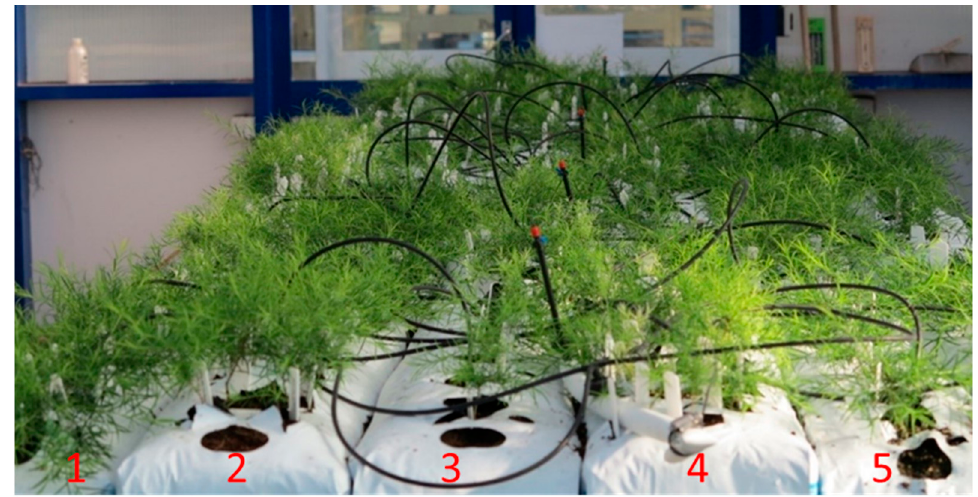
Figure 5. Stock plant growing conditions. Bag 1—(far left) pot mix high density (40 plants per bag; 200 plants/m 2 ), bag 2—coir medium density (20 plants per bag; 100 plants/m 2 ), bag 3—coir low density (6 plants per bag; 30 plants/m 2 ), bag 4—coir high density (40 plants per bag; 200 plants/m 2 ), and bag 5 —potting mix low density (6 plants per bag; 30 plants/m 2 ) pot mix.